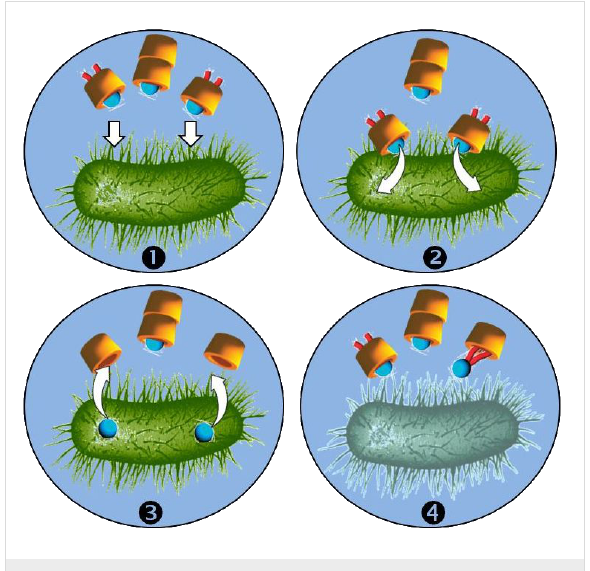
Table 4: Binding constants and geometries of various CD•didecyl- dimethylammonium chloride inclusion complexes and minimal